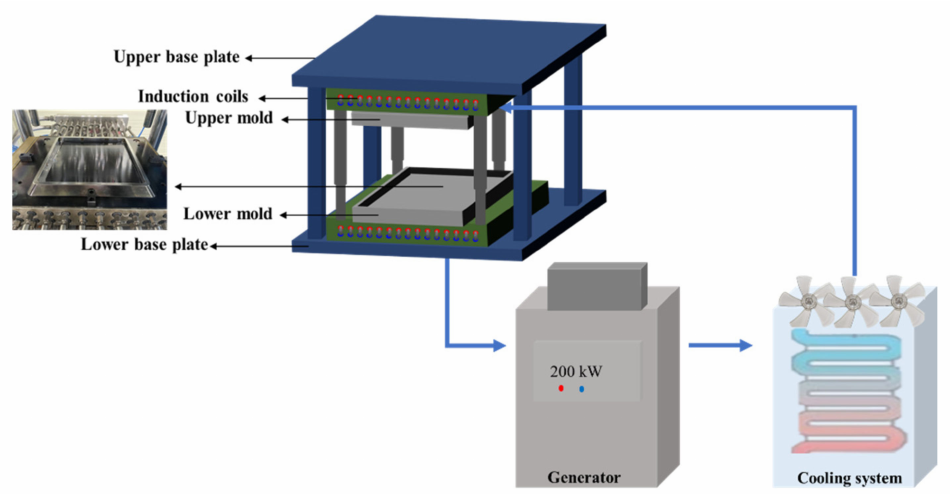
Figure 3. Schematic of the induction-heating molding